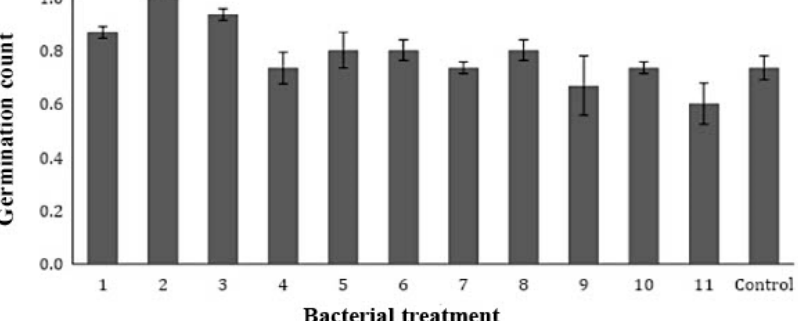
Figure 5. ( A ) Primary root growth of A. thaliana seedlings treated with bacteria isolated from seeds of Noccaea caerulescens . The seeds were sown on Vertical Agar Plates (VAPs) with 20 × basal medium and primary root growth was measured after 2 weeks. ( B ) Germination count of A. thaliana seeds treated with bacteria isolated from seeds of N. caerulescens . The seeds were sown on pots with heavy-metal-contaminated soil (Plombi è res, BE), and germination was counted after 2 weeks. A significant difference was analyzed by a one-way ANOVA Tukey HSD test and a significance level of p < 0.05 is indicated by an asterisk. All bacterial treatment numbers found on the x -axis correspond with Table 1.